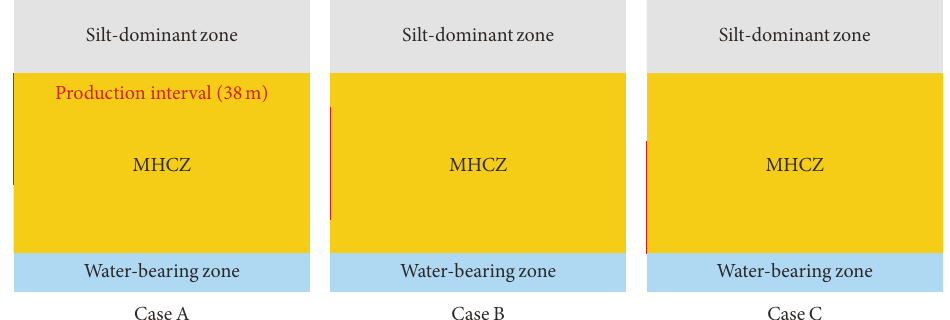
Figure 16: Different designs related to the location of production interval: Case A, from the top of the MHCZ (base case); Case B, at the center of the MHCZ; Case C, from the bottom of the MHCZ.